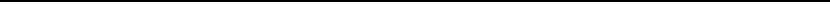
Table 2. Criteria 2: Genes (n = 18) in major blood pressure regulatory pathways associated with hypertension in genome wide association studies. The search was conducted on 05 / 11 / 2017 and a total of 188 records were identified.